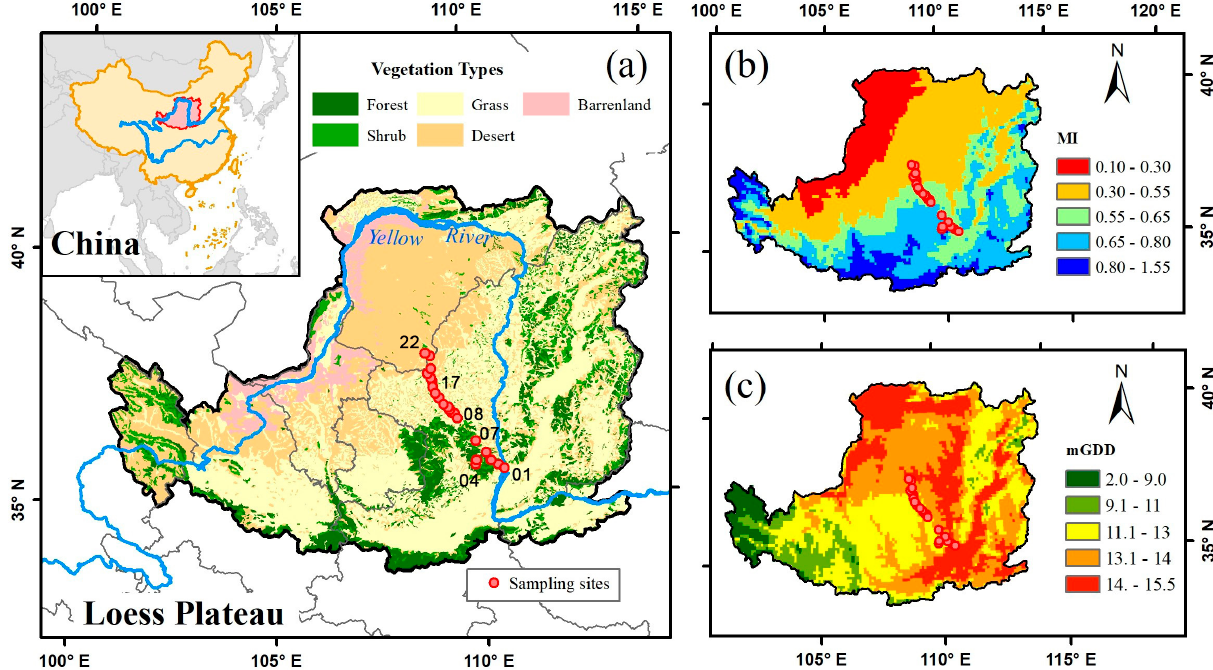
Figure 1. Distributions of the sampling sites across the aridity gradient on the Loess Plateau. ( a ) Vegetation distribution— the numbers represent the site IDs in Table 1. ( b ) Distribution map for moisture index (MI). ( c ) Distribution map for growing-season monthly mean temperature above 0 °C (mGDD 0 ).